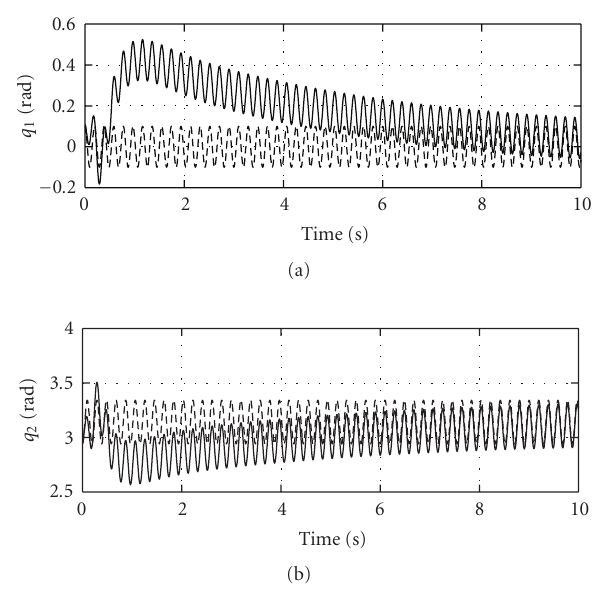
Figure 5: Time evolution of the output ( continuous line ) following the desired trajectory ( dashed line ) under perturbed